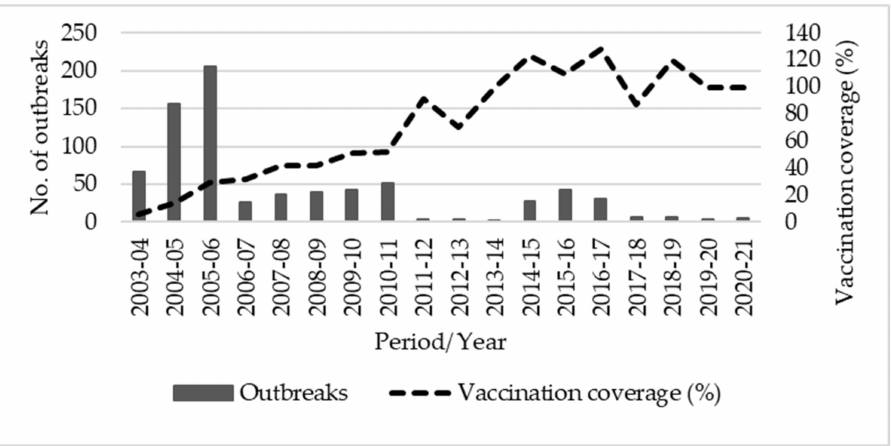
Figure 2. Reported PPR outbreaks and vaccination coverage in Karnataka between 2003–2004